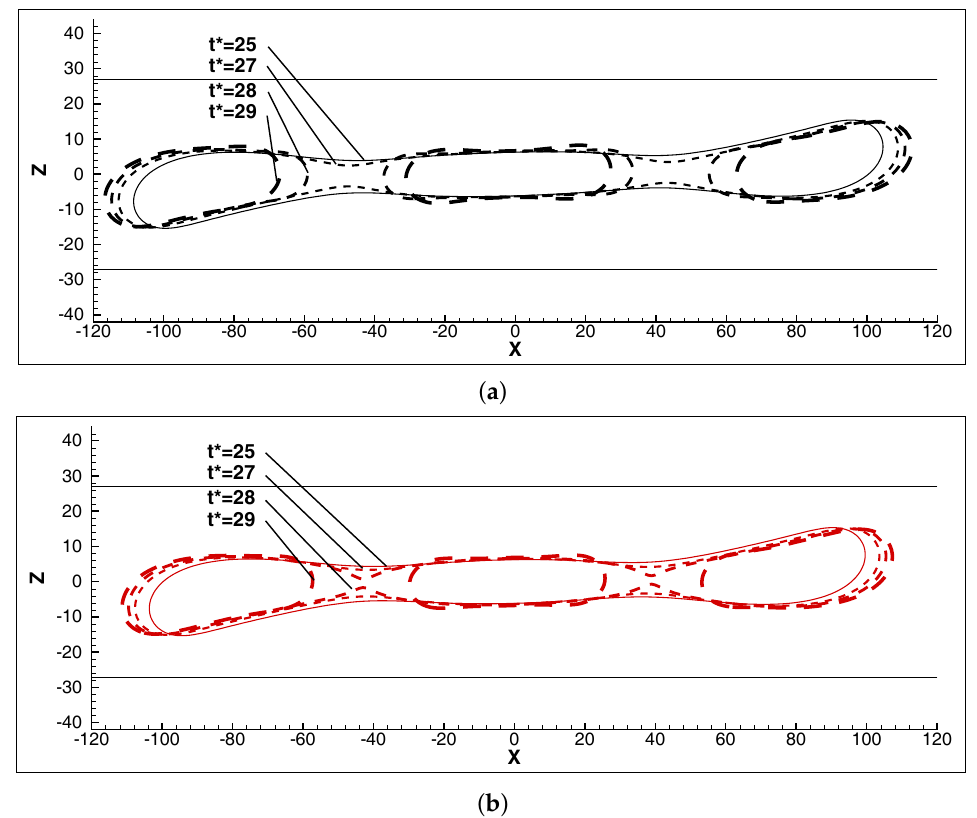
Figure 9. Transient droplet shapes close to the critical breakup time, in the x - z middle plane, in systems ( a ) N–N / λ = 3 and ( b ) PL–N / n d ≈